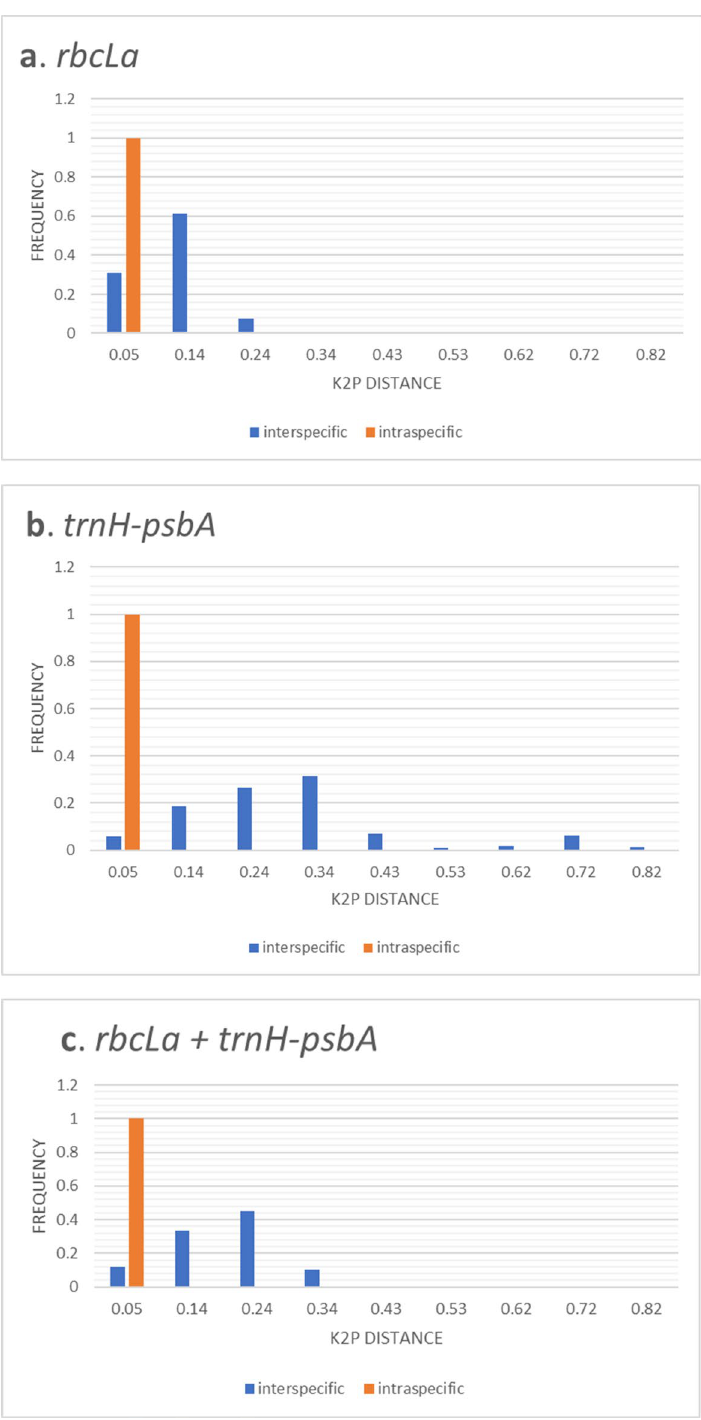
Figure 1. Distribution of interspecific and intraspecific K2P distances across all taxon pairs of ferns from Mixteca Alta, Oaxaca, obtained in partial gene rbcLa ( a ), intergenic spacer ( b ) and concatenated plastid regions ( c